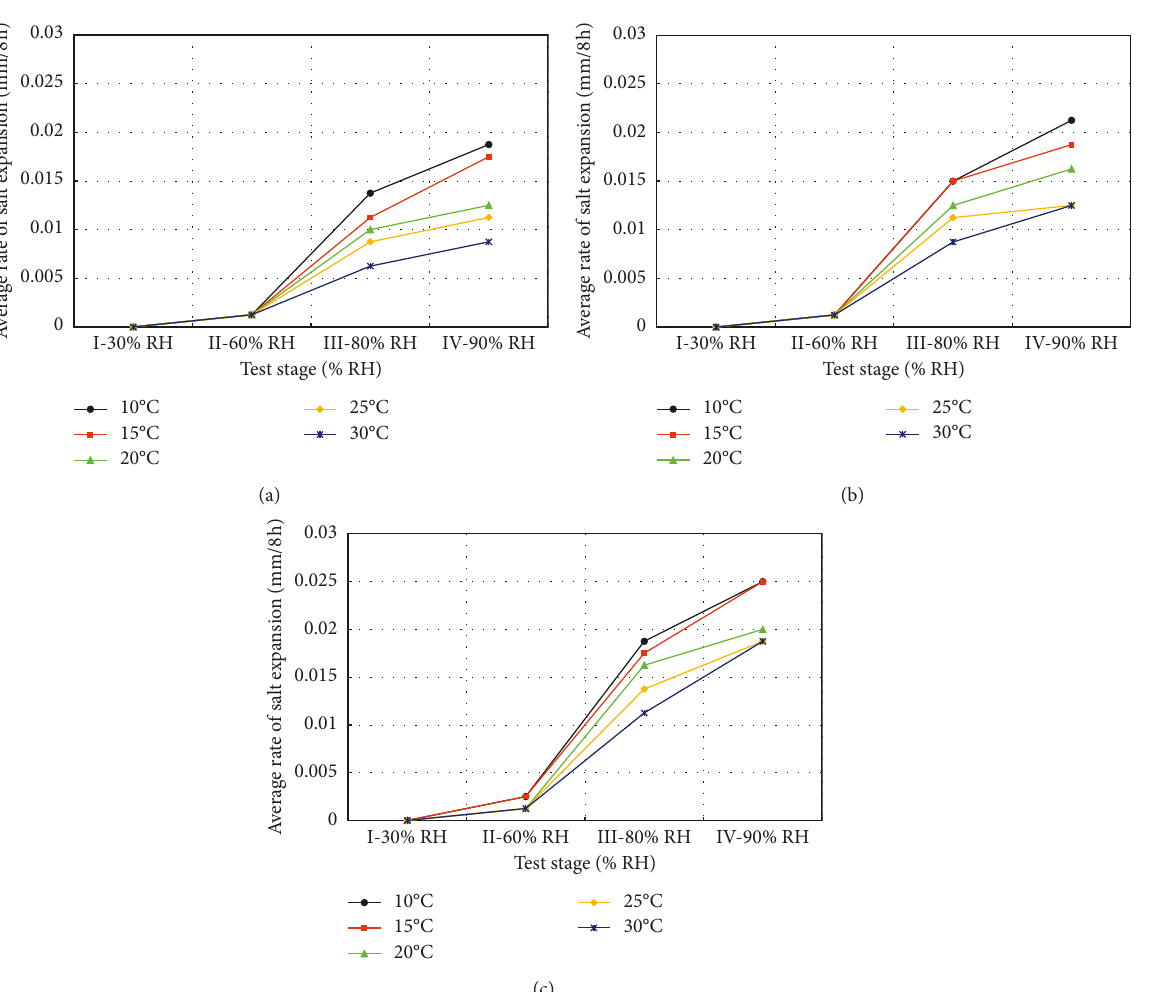
Figure 7: Salt expansion rate of sodium sulfate saline soil affected by RH. Salt content at (a) 2%, (b) 3%, and (c)